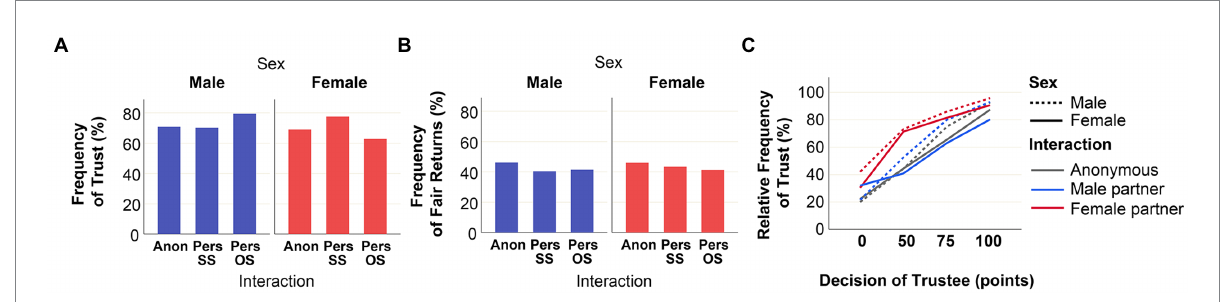
FIGURE 2 Overview of behavior in the Trust Game. (A) Percentage of cases where individuals in the role of trustor entrusted commodities to their interaction partner (the trustee). (B) Percentage of cases where individuals in the role of trustee returned a fair share of the revenue (= 100 points) to the trustor. (C) Association between trust (vertical axis) and trustworthiness (horizontal axis; expressed as the number of points returned to the trustee). The percentages in (A) and (B) are shown separately for males (blue) and females (red), and according to whether the decisions were taken in an anonymous setting (“Anon”), a personalized same-sex setting (“Pers SS”), and a personalized opposite-sex setting (“Pers OS”). The six curves in (C) represent the association between trust and trustworthiness for male (dashed lines) and female (solid lines) participants, dependent on whether they interacted with an anonymous partner (grey), a male partner (blue), or a female partner (red). Data from 176 subjects (89 males, 87 females) are shown, who subsequently participated in one anonymous interaction, two same-sex personalized interactions, and two opposite-sex personalized interactions. Only 699 of the 704 personalized interactions were included in the analysis (see Materials and